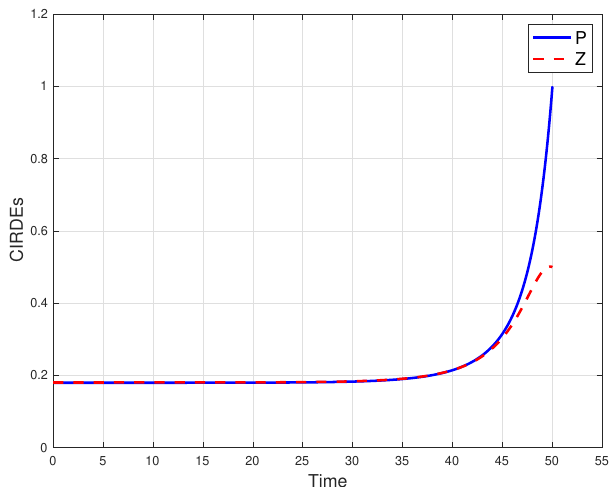
Figure 1. The evolution of the coupled integro-Riccati differential equations (CIRDEs) in (6) and (7) for the example of the mean-field-type mean-variance differential game.